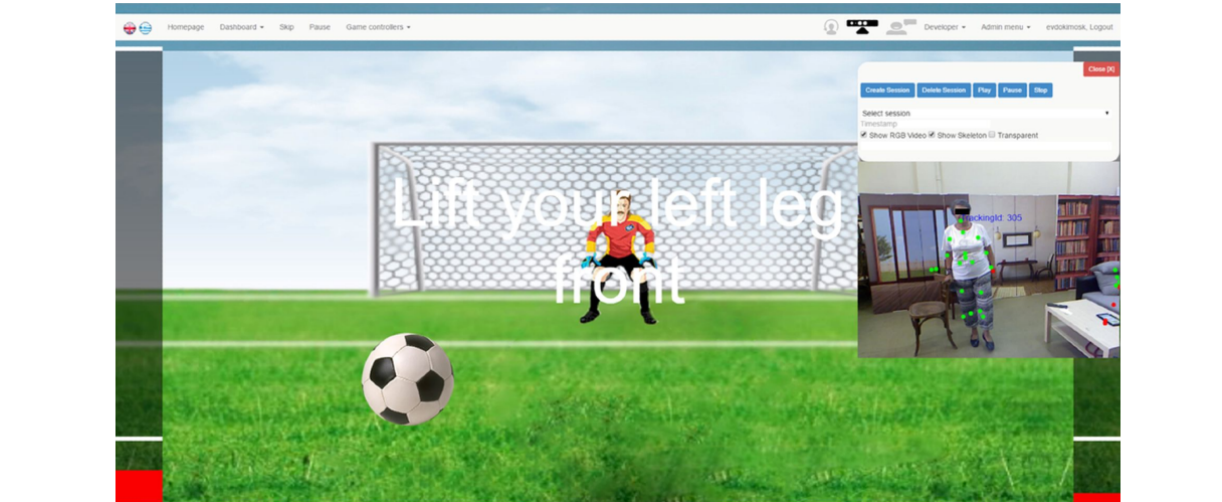
Figure 2. webFitForAll